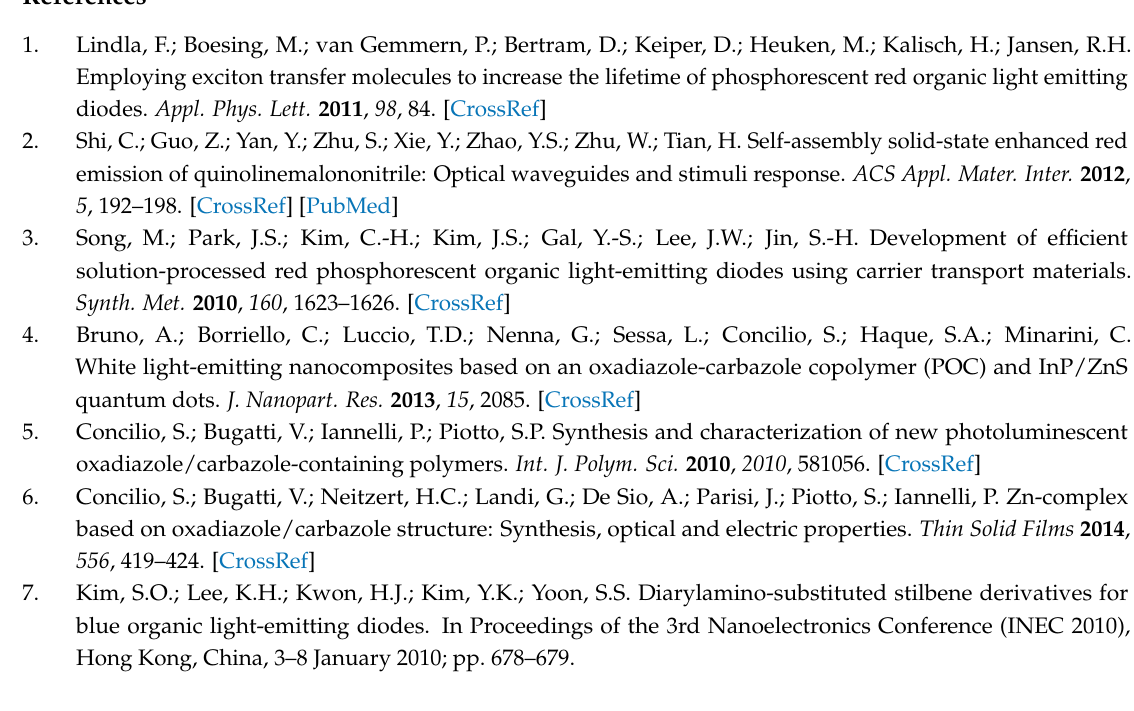
Supplementary Materials: The following are available online, Table S1: Crystallographic data and structural aromatic centroids. Figure S2: Molecular ribbon of CN-PV-NHMe propagating in the (1 –1 0) direction. Figure S3: